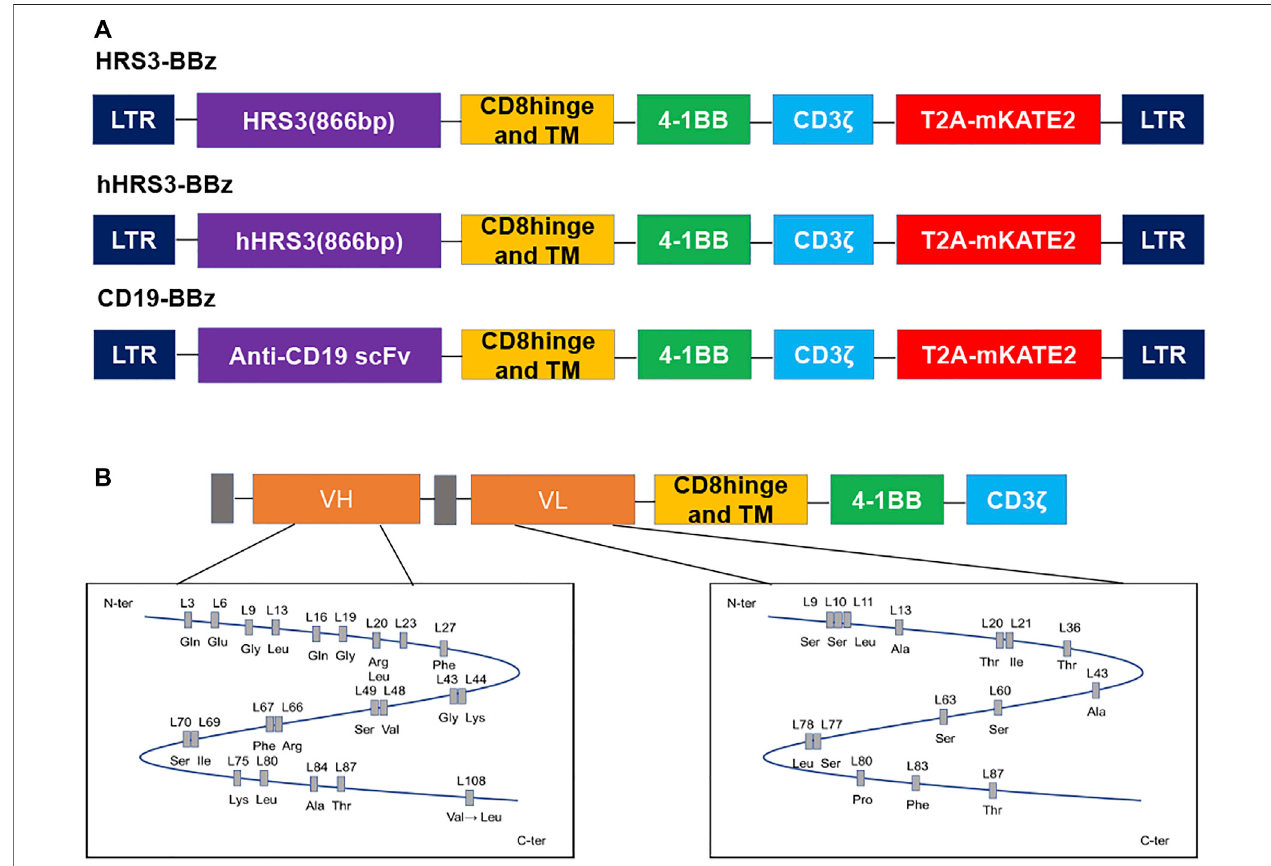
FIGURE 1 | Schematic diagram of the humanized HRS3-chimeric antigen receptor (CAR) construct and its differences from the murine receptor. (A) Schematic representation of CD19-CAR, HRS3-CAR, and hHRS3-CAR. All CARs had hinge, transmembrane, and CD8, and a CD3 ζ T-cell activation domain. The mKATE2 is far- red fl uorescentprotein.Inthisstudy,themKATE2domainwasusedtotracetheexpressionofCARbyfusingtotheN-terminalofCARviaaself-cleavingT2Apeptide. (B) Humanization of the HRS3 VL domain required 18 amino acid exchanges while retaining one amino acid from the murine framework sequence, whereas for the HRS3VH domain, 27amino acidswere exchangedand four murineresidues wereretained(Schlapschyet al.,2004).The fi gure shows the schematic diagram ofamino acids after mutation.